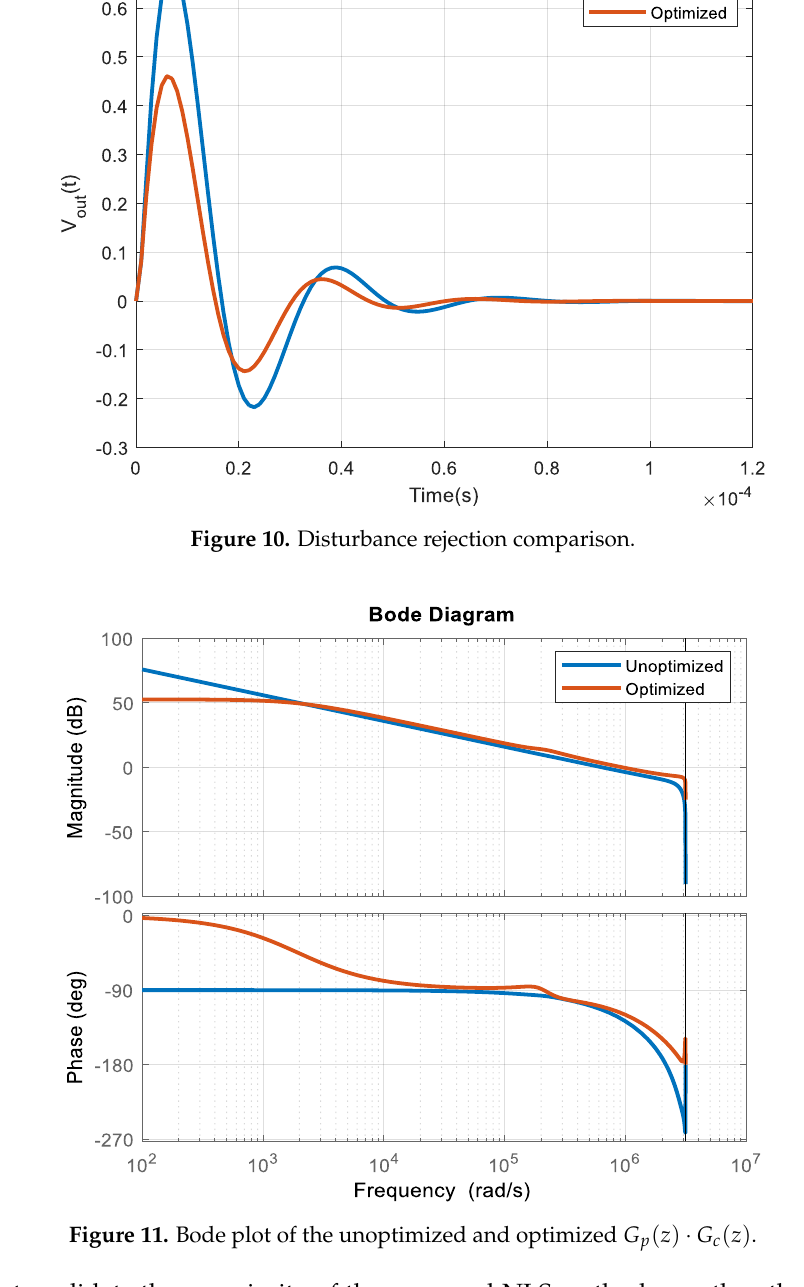
Figure 11. Bode plot of the unoptimized and optimized G p ( z ) · G c ( z ) .